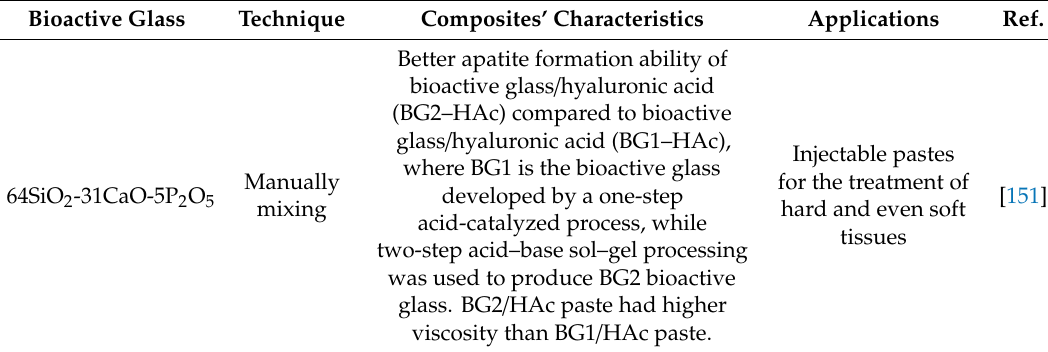
Table 4. Summary of hyaluronic / bioactive glass